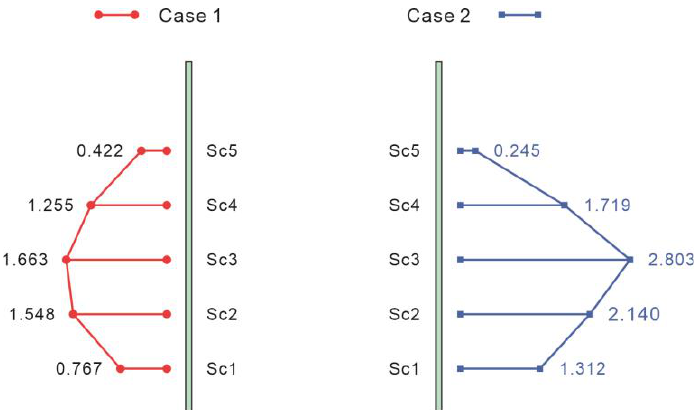
Figure 10. Distribution of the bending moment along the depth of sheet-pile walls (PGA = 0.10 g). (Unit: N·m).